Question: Summarize what this figure shows in one sentence.
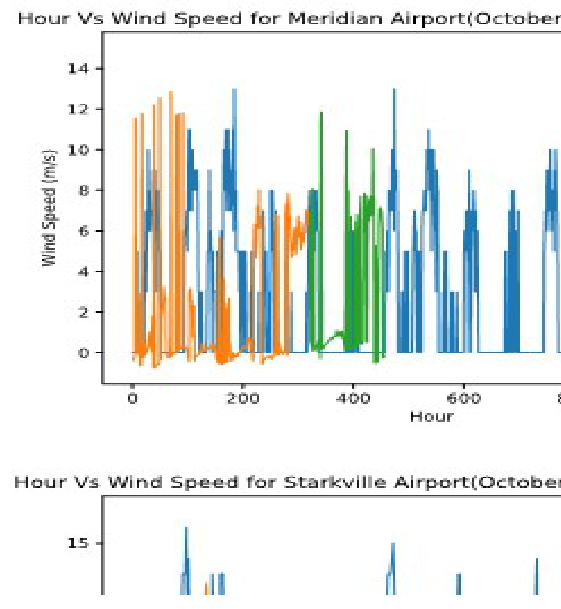
Answer: MERIDIAN VS. STARKVILLE FOR THE MONTH OF